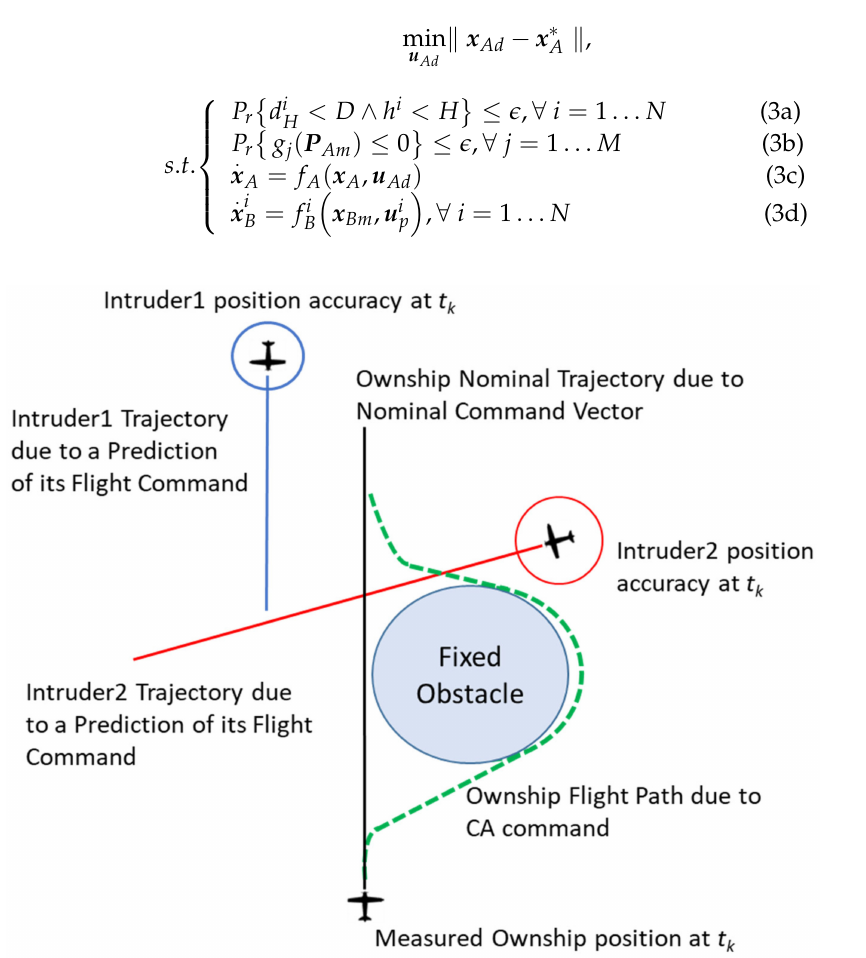
Figure 3. Optimal CA maneuver in a scenario characterized by air traffic and fixed